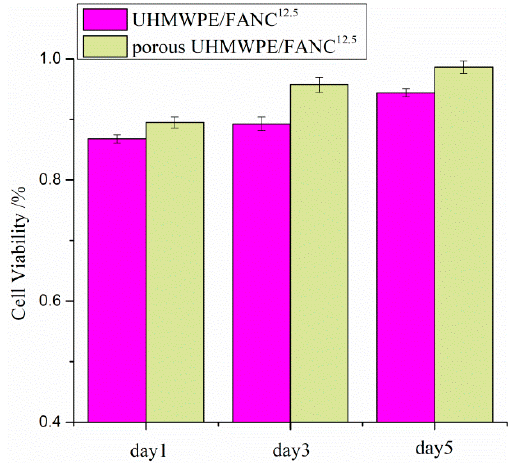
Figure 8. Cell viability of NIH 3T3 cells incubated with UHMWPE/FANC 12.5 and porous UHMWPE/FANC 12.5 ( p < 0.05).